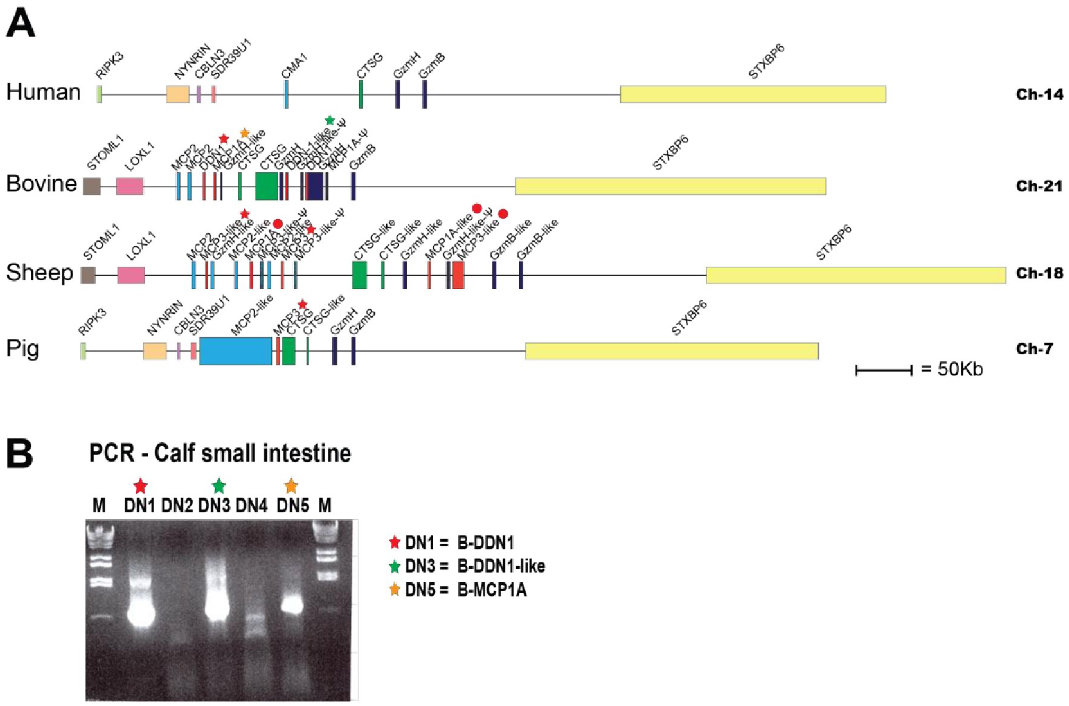
Fig 2. The chymase locus and a PCR analysis of the expression of duodenases in cow duodenum. The chymase locus of four mammalian species, human, bovine, sheep and pig is presented in panel A. This is an in-scale presentation of this locus including a few flanking non-lysozyme genes. Panel B shows a PCR analysis of the originally five duodenases in the early version of the cow chymase locus. As can be seen from the figure, only three of the genes show a detectable PCR band of the correct size. In a recent genome update it has been shown that these three genes are complete and most likely functional and the fourth is a pseudogene. This locus does now in the most recent genome update only contain four duodenase genes, three active and one pseudogene. The most recent update of the sheep locus now contains five duodenase genes where four seems to be functional. The second MCP3-like marked with a red dot is most likely non-functional. The genes we have characterized are marked with stars and the ones not yet analysed by red dots. The stars for the bovine enzymes are colour coded as for panel B, the PCR